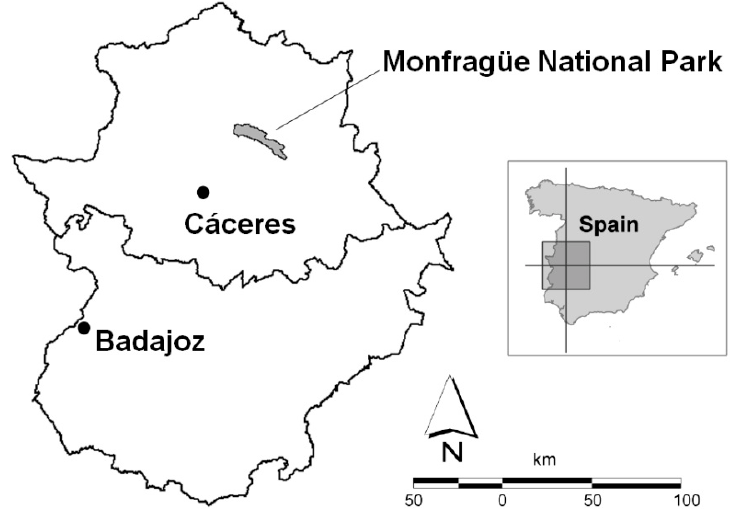
Figure 1. Location map of Badajoz, Cáceres and the Monfragüe National Park, with reference to the Autonomous Community of Extremadura and Spain.